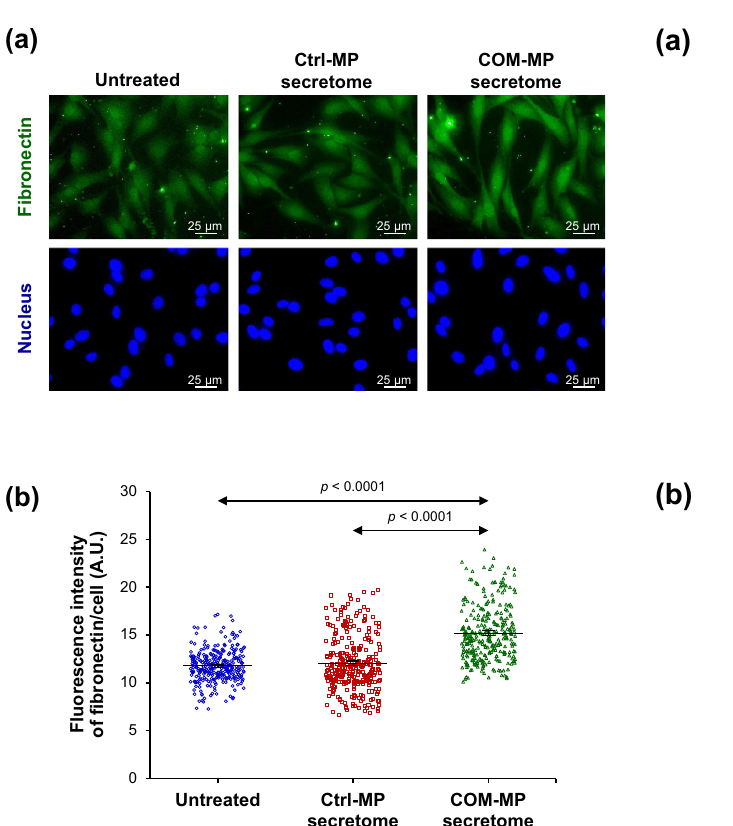
Fig. 8 Effects of COM-MP secretome on fi bronectin level in BHK-21 renal fi broblasts. BHK-21 cells were incubated in fresh serum-free medium without any treatment (untreated control) or in fresh serum-free medium mixed 1:1 (v/v) with Ctrl-MP secretome or COM-MP secretome for 24 h. a Immuno fl uorescence staining of fi bronectin was done using mouse monoclonal anti- fi bronectin as a primary antibody, whereas secondary antibody was conjugated with Alexa Flour 488. Nuclei were stained in blue using Hoechst dye. b Quantitative analysis of fl uorescence intensity of fi bronectin was obtained from at least 100 cells in ≥ 10 random HPFs for each sample using NIS-Elements D V.4.11 (Nikon). The data were obtained from three independent experiments using different biological replicates and the bars indicate mean ± SEM (all the source data are presented in Supplementary Data 5). A.U. = arbitrary unit.